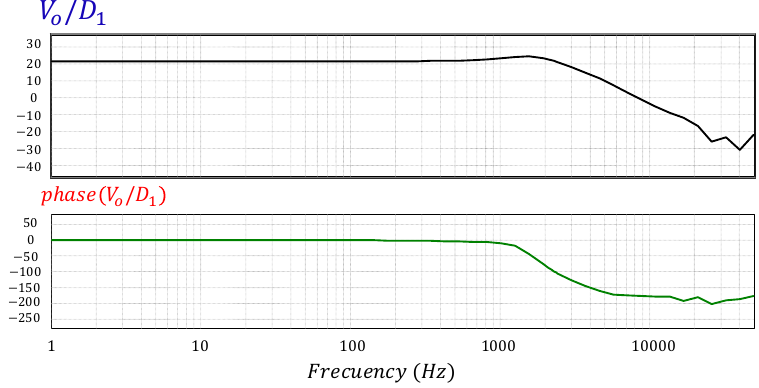
Figure 6. Control scheme.